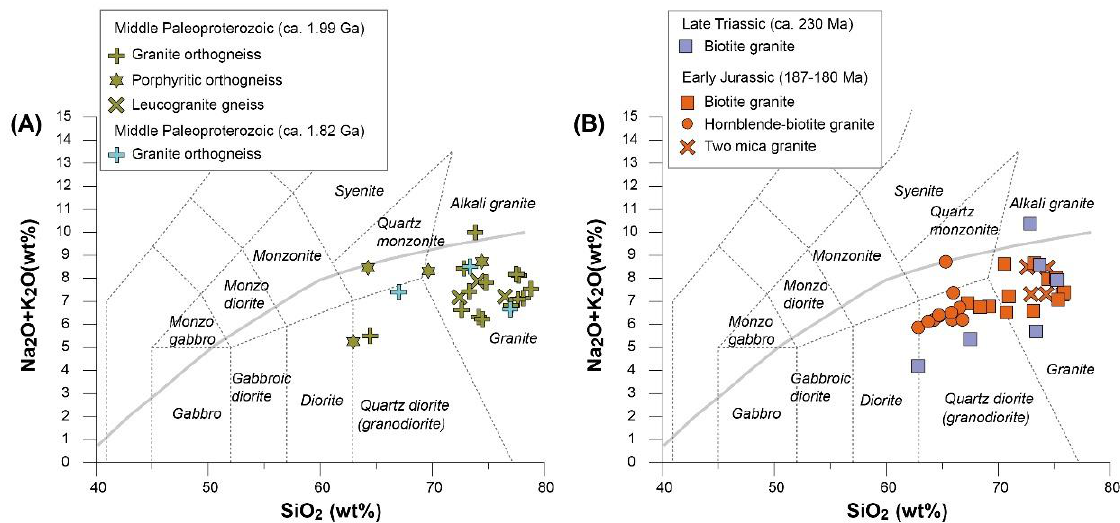
Figure 6. SiO 2 wt.% versus Na 2 O+K 2 O wt.% diagram for the Middle Paleoproterozoic orthogneisses ( A ), and Late Triassic granite and Early Jurassic granitic rocks ( B ) in the Jangsu-gun area.